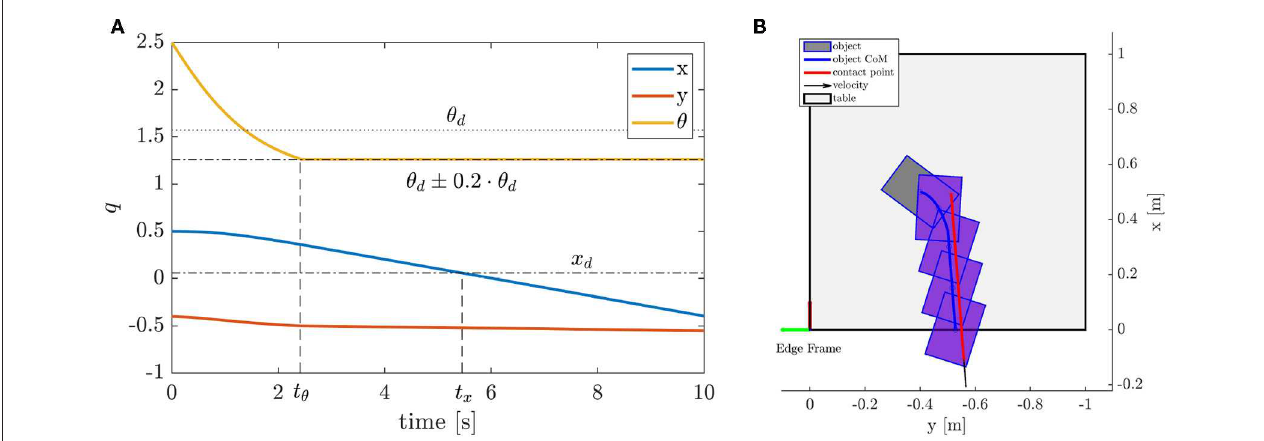
FIGURE 7 | Strategy 2 Pivot and Re-Grasp–optimal object trajectory. (A) object coordinates, (B) trajectory visualization.